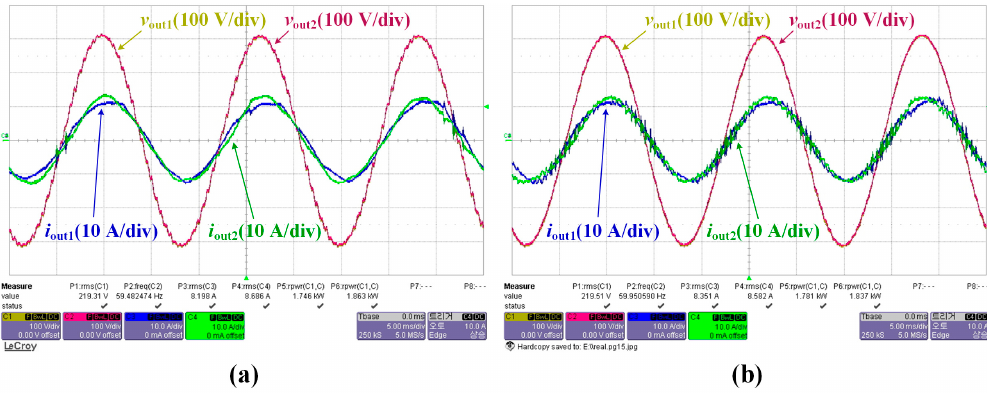
Figure 15. Experimental waveforms of using ( a ) conventional droop control and ( b ) the proposed control strategy with R–L load (12.4 Ω + 6 mH).